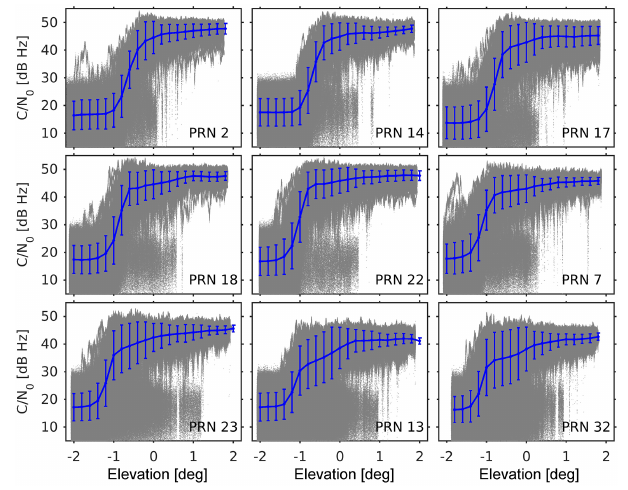
Figure 9. Carrier signal-to-noise density ratio, averaged over the two O/L channels, as a function of elevation angle. The panels show observations from nine PRNs sorted row-wise according to increas- ing azimuth angle (see Fig. 4). Mean and 1 σ standard deviations, calculated from 0 . 2 ◦ elevation bins, are marked in dark blue. Once the signal is completely blocked by the horizon, C /N 0 drops to about 17dBHz (see Eq. 8).